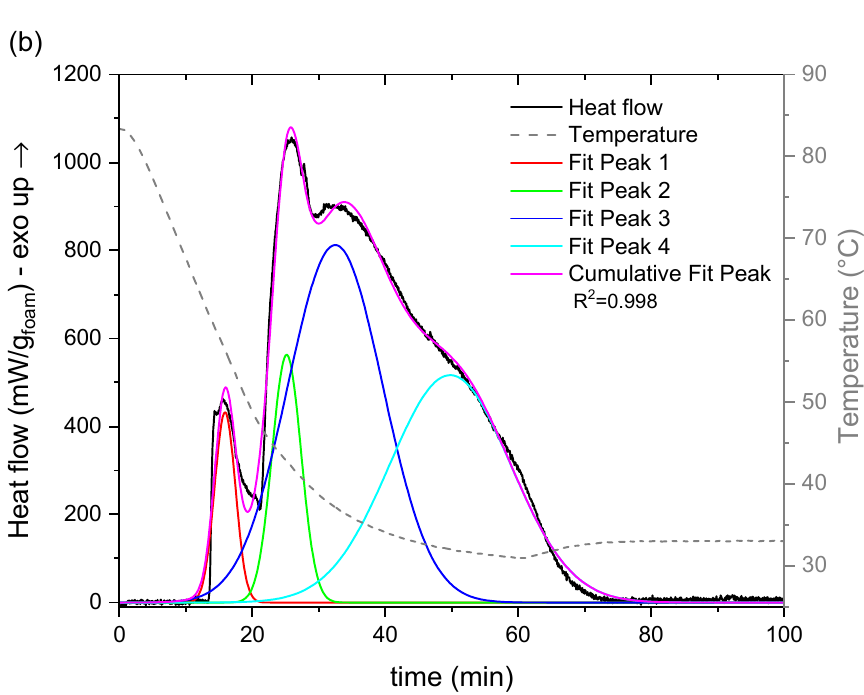
Figure 7. ( a ) TG/DSC profile of LiCl-PDMS foam under the temperature drop of 80–35 °C at 12 mbar of water vapor pressure, corresponding to 10 °C of evaporation temperature. ( b ) Deconvolution of DSC profile.